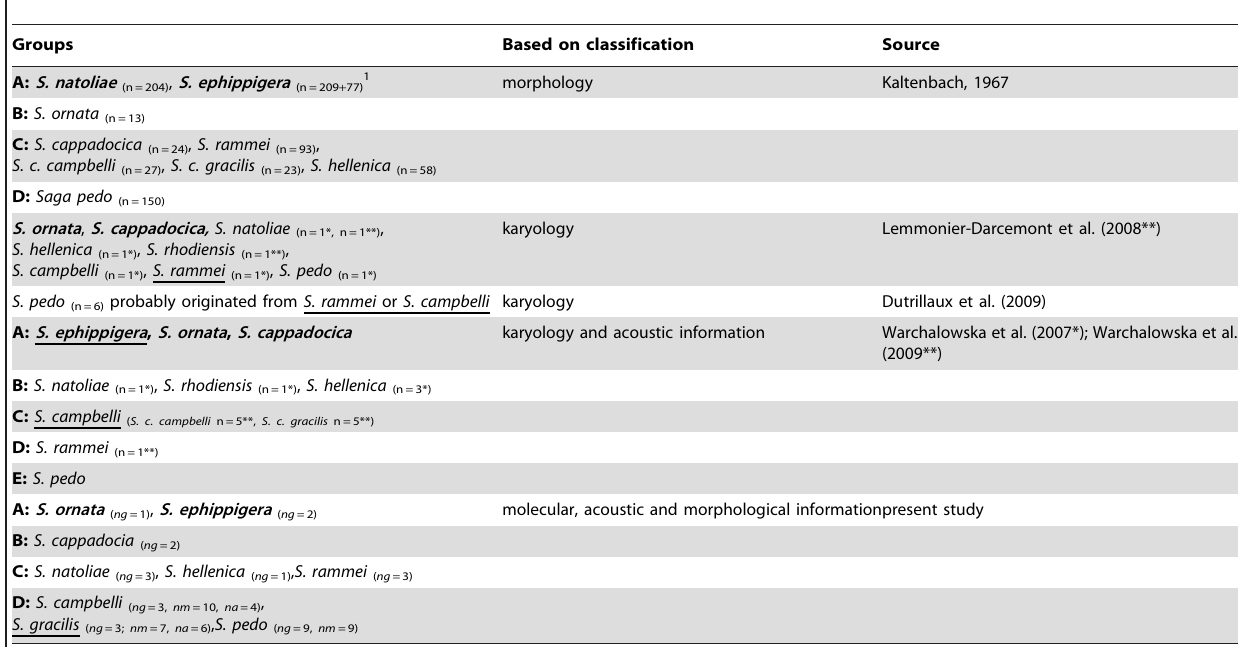
Table 3. Comparative data on the phylogenetic relationship of Saga